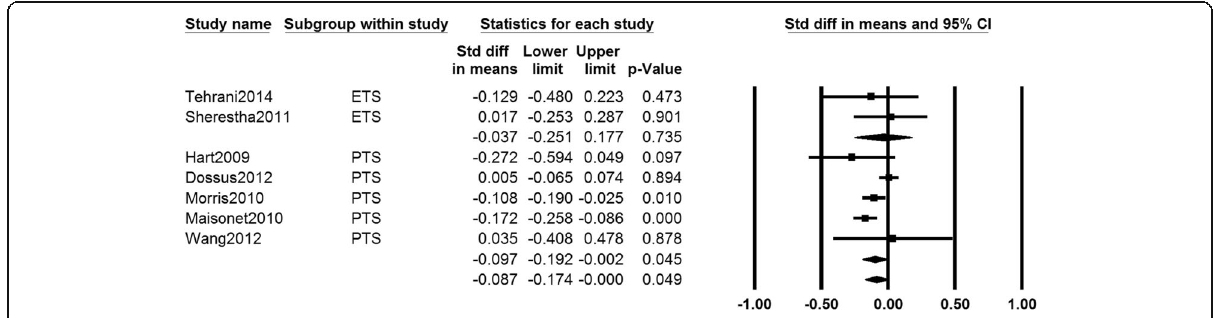
Fig. 2 Forest plot for the age at menarche between the PTS or ETS group and control group